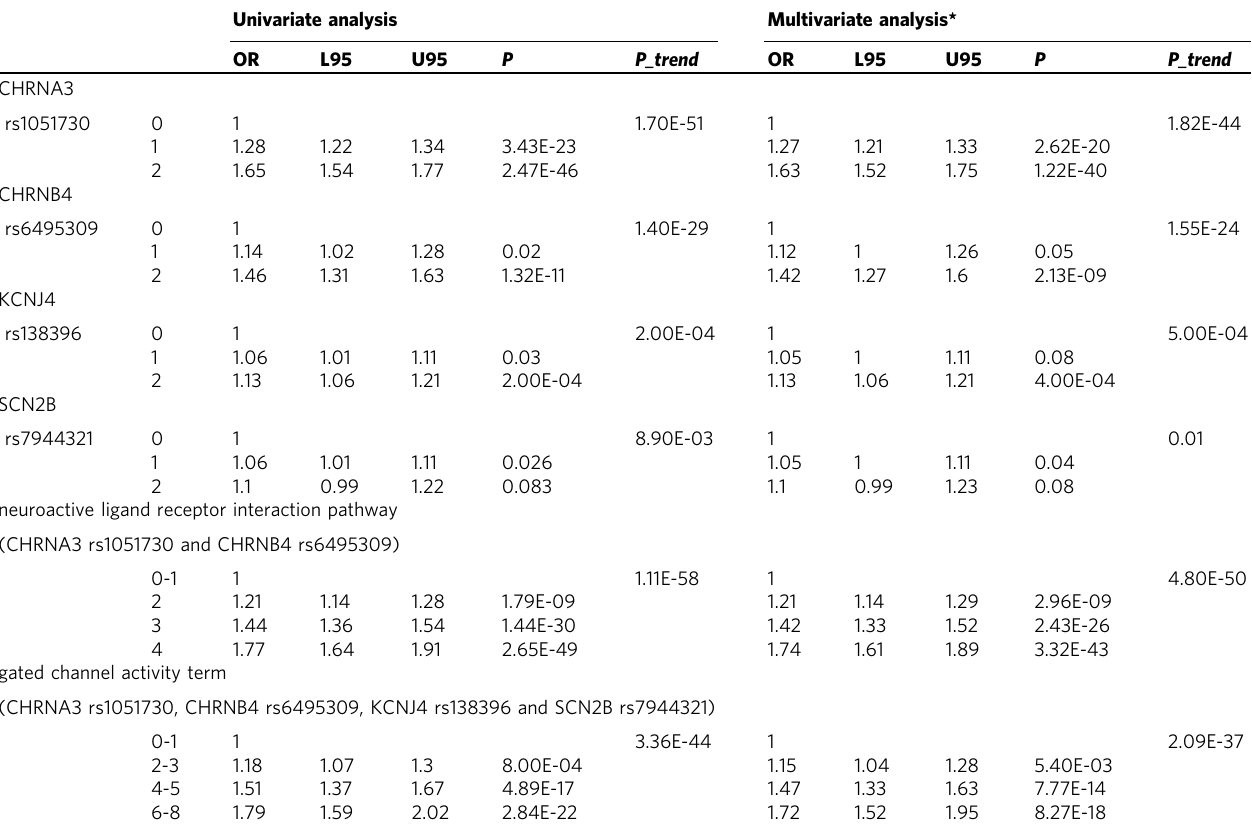
Table 6 Individual and combined effects of SNPs from our susceptibility pathways on lung cancer risk in Replication